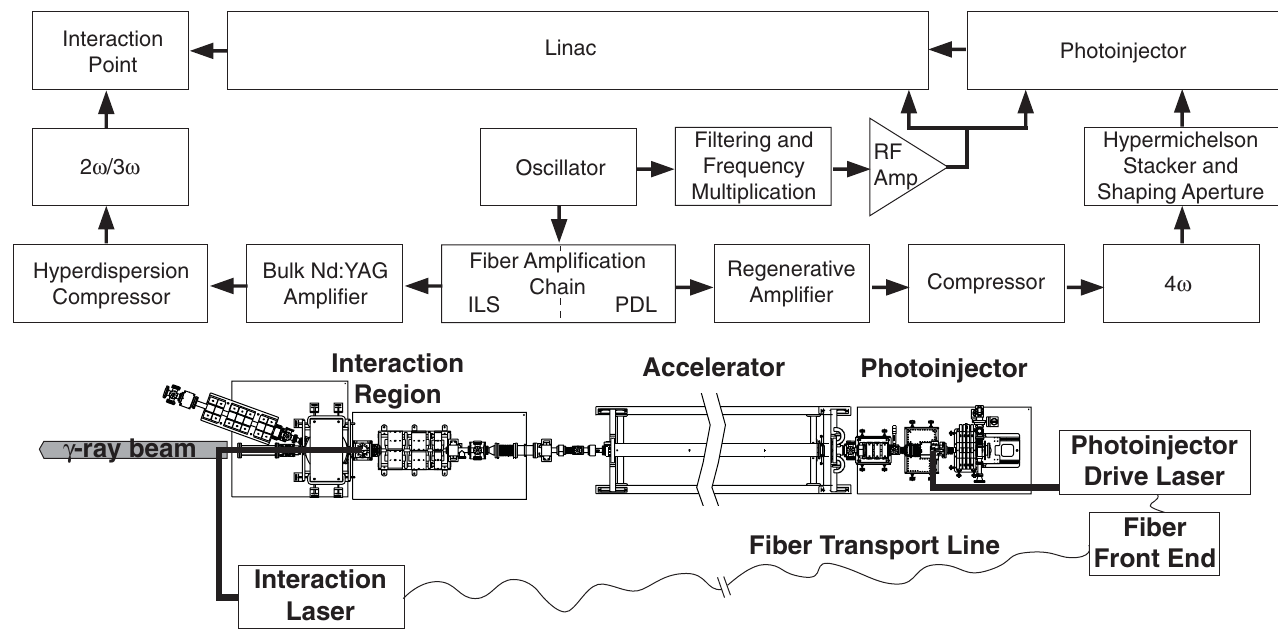
FIG. 1. Top: A block diagram of the T-REX system, showing all the subcomponents described in detail in the text. Bottom: A schematic of the integrated